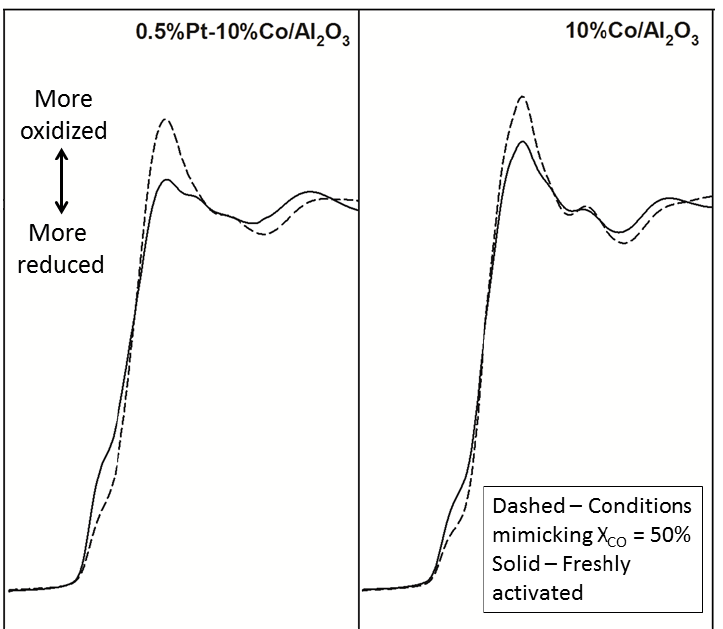
Figure 4. ( left ) Pt promoted and ( right ) unpromoted 10%Co/Al hydrogen activation (550 °C for unpromoted and 400 °C for Pt-promoted) and (dashed) after exposure to H , CO, and H O partial pressure ratios mimicking X 2 2 (adapted with permission from [36] Copyright 2014,